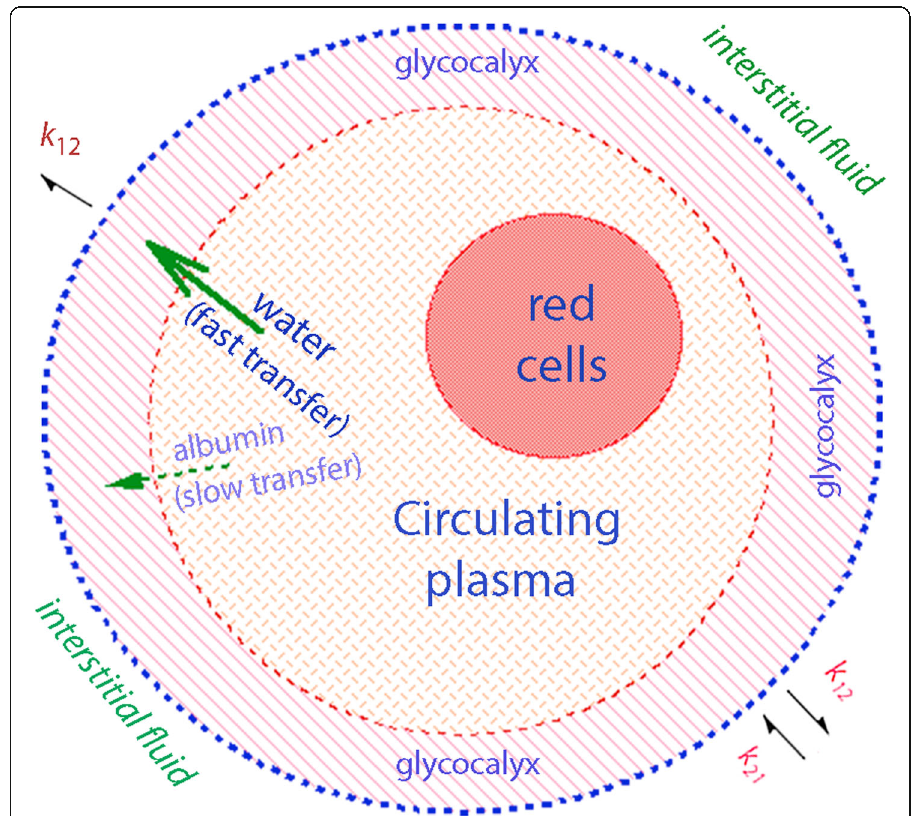
Fig. 1 Schematic drawing of circulation in which red blood cells and plasma is closed off from the glycocalyx layer while infused fluid penetrates easily. Albumin enters the glycocalyx slowly and finally leaks out to the interstitial fluid via endothelial clefts. The capillary leakage of fluid occurs much faster and, at any moment, is the product of the volume expansion of the plasma and the glycocalyx layer and the rate constant k 1 2 . The so-called F-cell ratio might be due to the difference between red blood cells and plasma with regard to their access to the glycocalyx